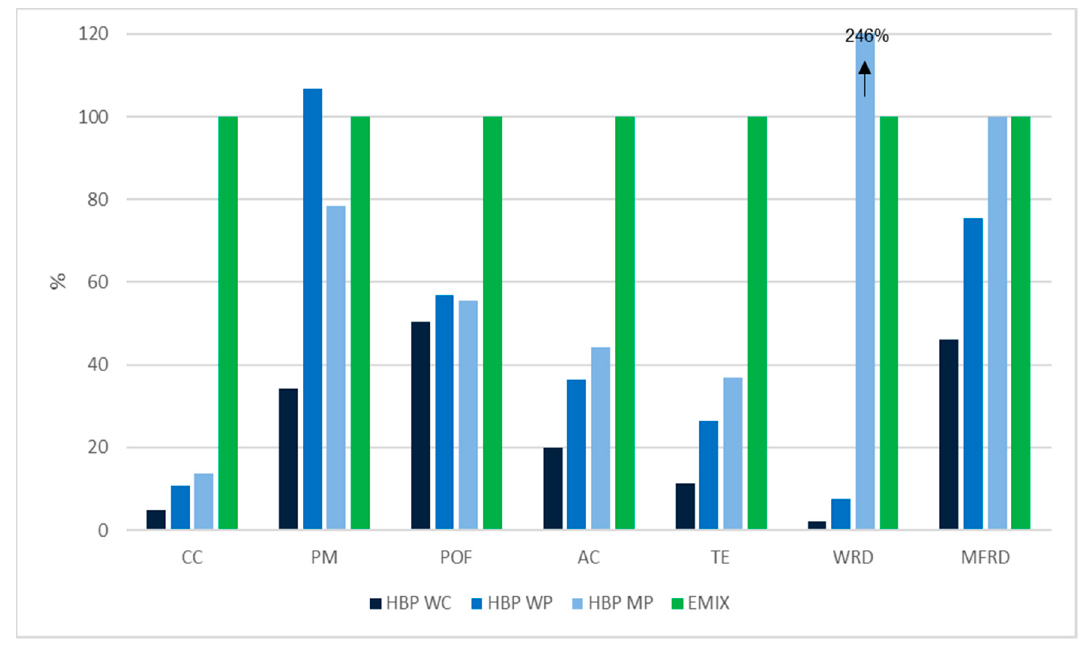
Figure 8. Comparison of HBP technology with competing technologies (for 1 kWh electricity). Values are normalized taking as 100% the impacts of the German electricity mix. CC = Climate change, PM = Particulate matter, POF = Photochemical ozone formation, AC = Acidification, TE = Terrestrial eutrophication, WRD = Water resource depletion, MFRD = Mineral, fossil, and renewable resource depletion. WC = wood chips, WP = wood pellets, MP = Miscanthus pellets.